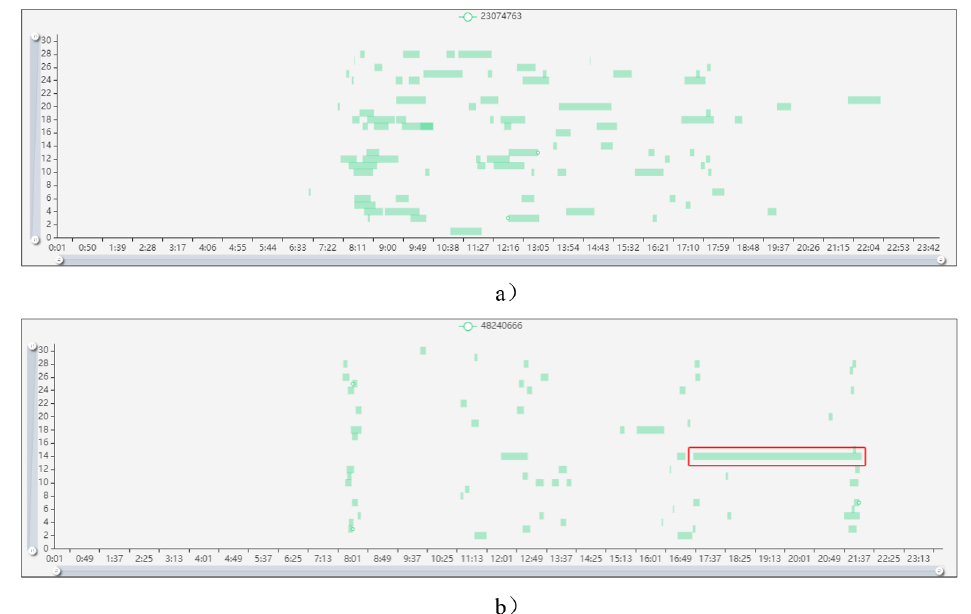
Figure 3. Abnormal card pixel matrix view ( a ) Anomaly card 23074763 pixel matrix view, ( b ) Abnormal travel time